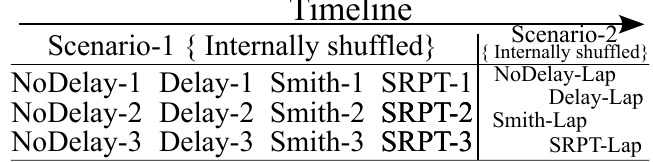
Figure 13. Randomization of test runs for each